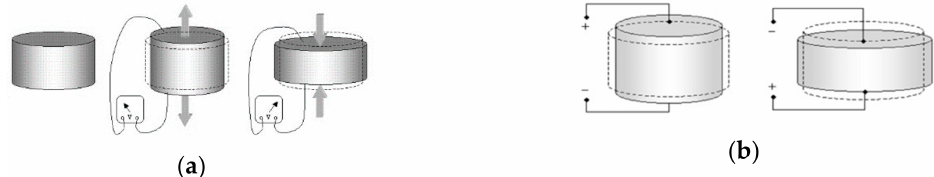
Figure 1. Piezoelectric effect: ( a ) Direct effect; ( b ) Inverse